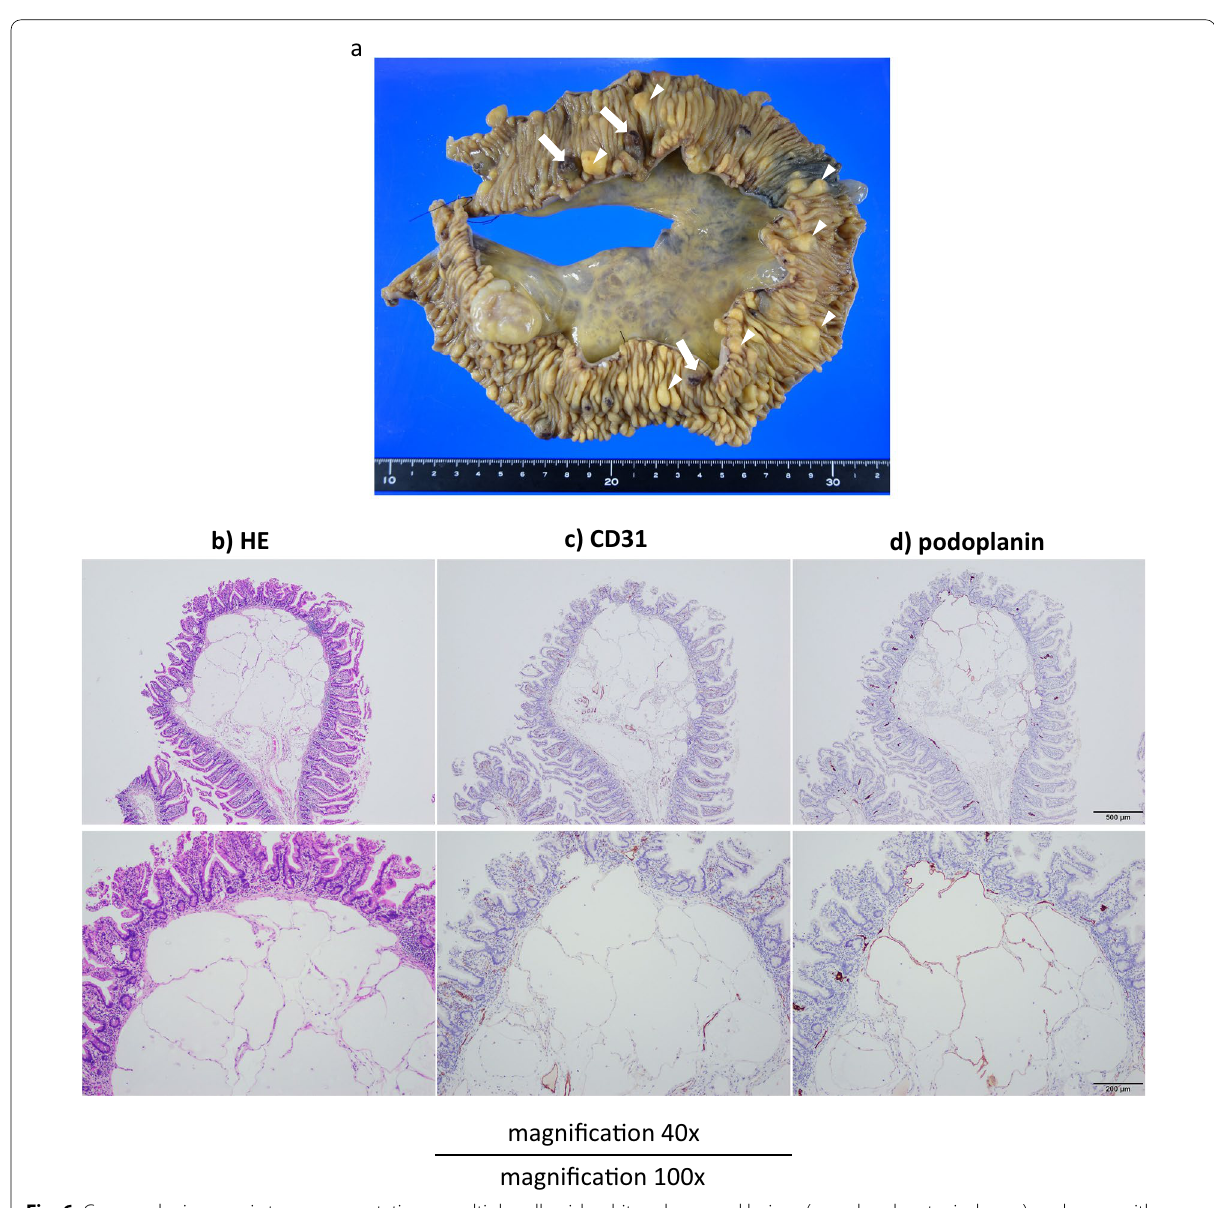
Fig. 6 Gross and microscopic tumor presentation: a multiple yellowish-white submucosal lesions (arrowhead on typical ones), and some with traces of post-hemorrhage (arrow); b hematoxylin and eosin stain, magnification 100; and d podoplanin immunostain, magnification × immunostaining, and negative for